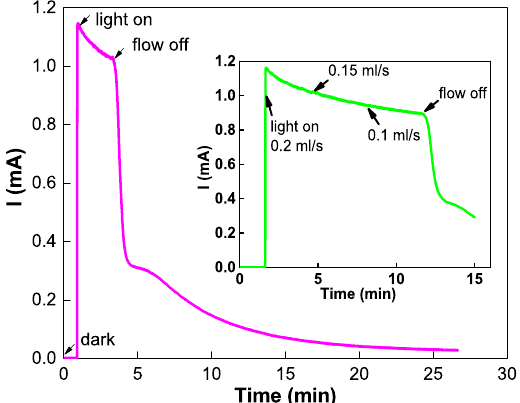
Figure 2. Photoelectrochemical response of the all-V continuous-flow PESC to flow of vanadium electrolytes. The anolyte and catholyte are 0.01 M VO 2 + and 0.01 M V 3 + (balanced with 3 M H 2 SO 4 ), respectively. The photoanode is a TiO 2 electrode. The flow rates of the anolyte and catholyte were varied